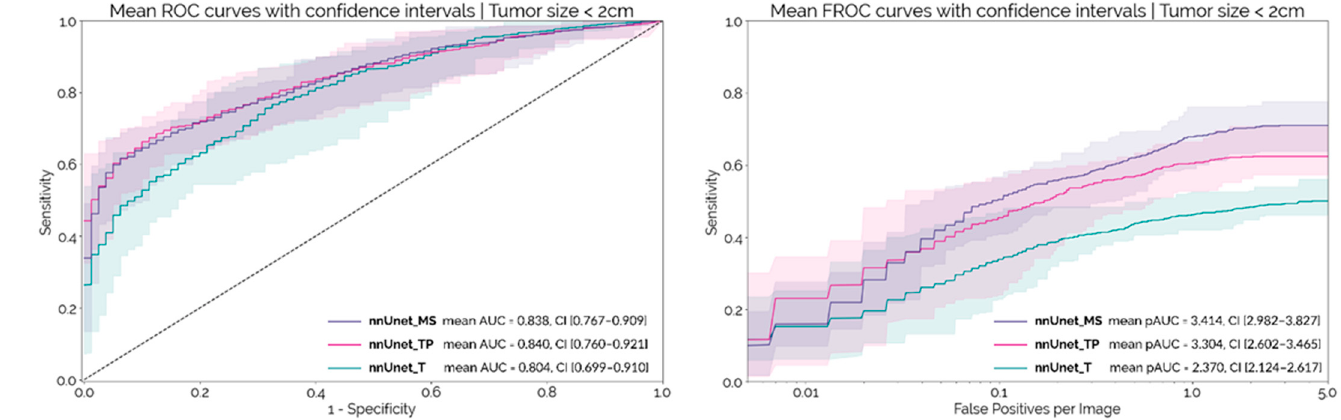
Figure 3. Mean ROC and FROC curves with respective confidence intervals for the external set considering only the subgroup of tumors < 2 cm in size. Table 3. Ensemble results for the area under the ROC curve (AUC-ROC) and partial area under the FROC curve (pAUC-FROC) from configuration on the whole test set and the subgroup of tumors < 2 cm in